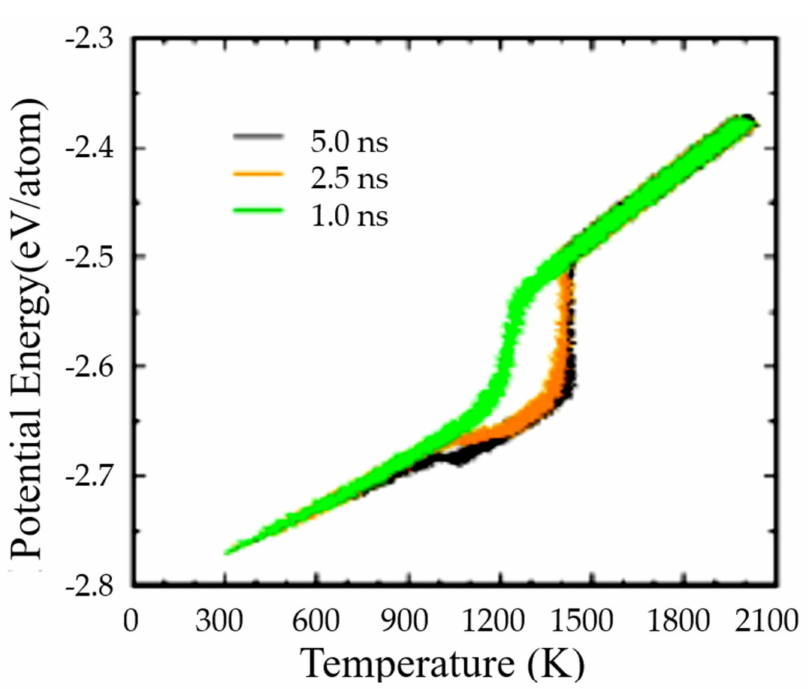
Figure 7. MD simulations of liquid silver observing a melting temperature of 1391 K during heat- ing a 32,000 atoms system instead of T m = 1234.9 K (5 ns with R = 0.34 × 10 12 K/s, 2.5 ns with R = 0.68 × 10 12 K/s and 1 ns with R = 1.7 × 10 12 K/s). Reprinted with permission from [45]. Copy- right 2020 American Chemistry Society